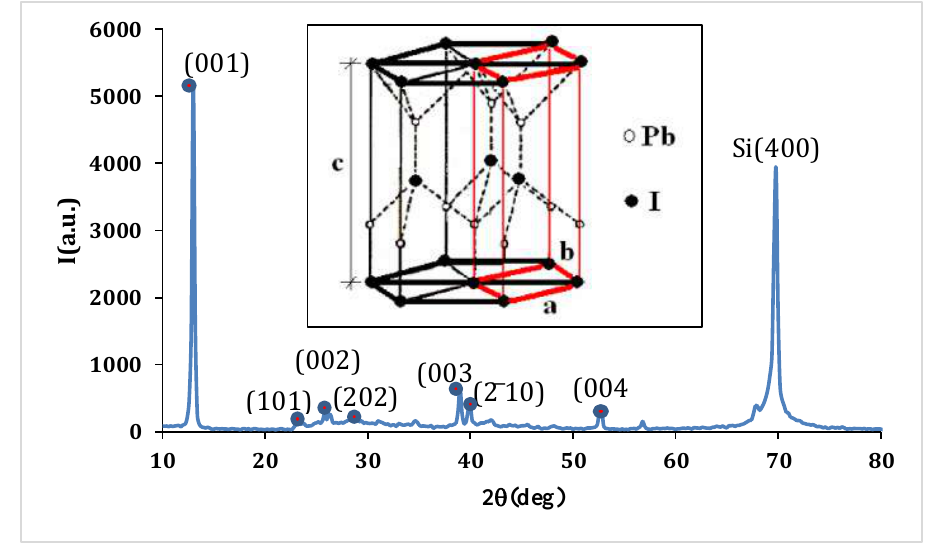
Figure 6 : XRD pattern for Pb I₂ thin film prepared by vacuum thermal evaporation